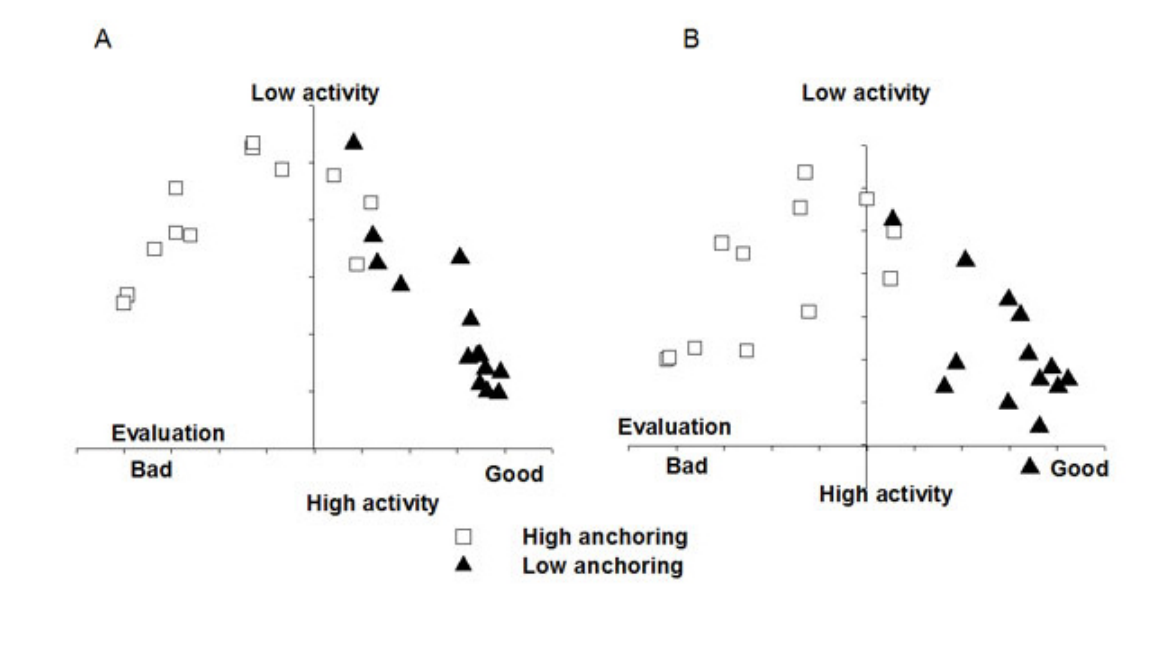
Fig. 3 . Assessment of coral reef sites associated with high and low intensities of anchoring using the first two perceptual dimensions provided by participants who had a working association with coral reefs (A) and those who did not (B). The first perceptual meaning given to the coral reef environment was an evaluation, and the second was the amount of perceived activity. Each point represents one of the 26 photographs and where it was placed in the two-dimensional space described by the principal component